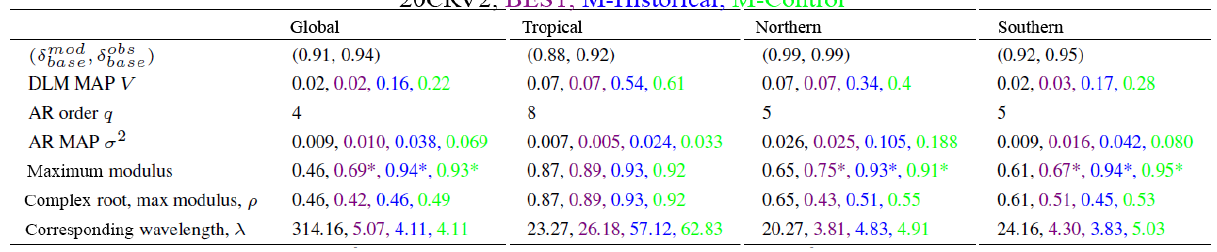
and observation baseline discount factor δ obs . DLM smoothed estimates of residual variance, Table 2. Model baseline discount factor δ mod base base V . AR order q and MAP of AR variance σ 2 . Overall maximum modulus with ∗ indicating correspondence to real roots, maximum complex modulus, and corresponding wavelength (months) calculated from the AR MAP characteristic polynomial.